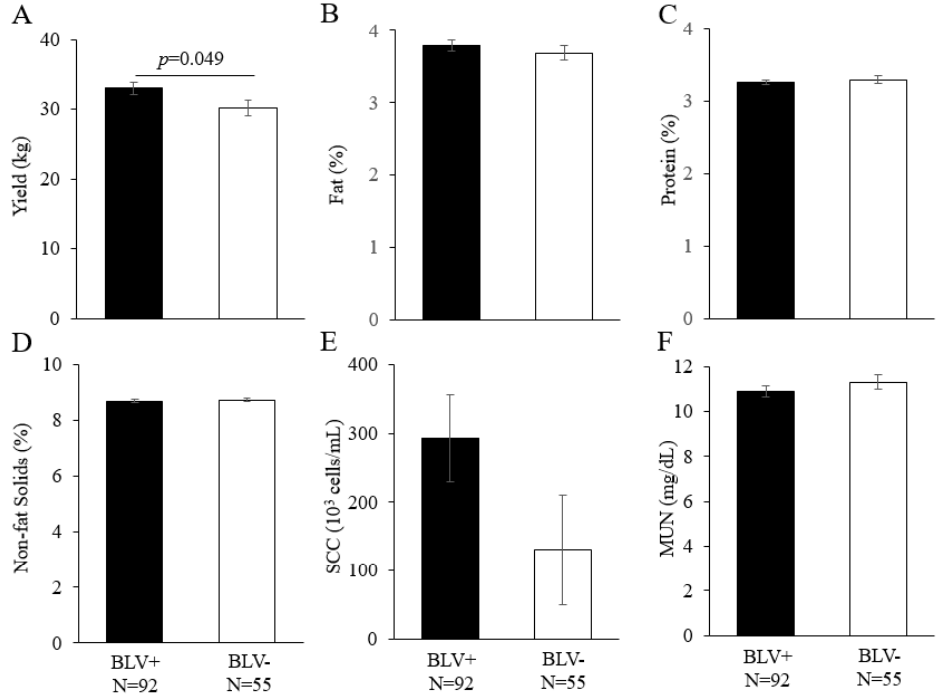
Figure 3. Effects of BLV infection on dairy cattle productivity (( A ) yield (kg), ( B ) fat (%), ( C ) protein (%), ( D ) non-fat solids (%), ( E ) SCC (10 3 cells/mL), and ( F ) MUN (mg/dL)). The results of the linear model analysis showed significant differences in the following factors: ( A ) lactation period; ( B ) farm and lactation period; ( C ) farm, lactation period, and calving number; ( D ) farm, lactation period, and calving number; ( E ) none; ( F ) farm and lactation period. A least-squares analysis of variance was performed in addition to the factors for which significant differences were found. BLV, bovine lym- phoma virus; MUN, milk urea nitrogen; SCC, somatic cell count. BLV infection was determined by CoCoMo-qPCR-2. BLV+ = BLV positive dam; BLV−, BLV negative dam; N, number of tested dams.